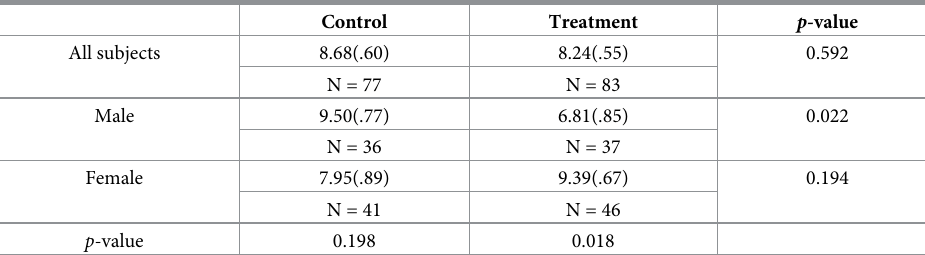
Table 4. Switching point